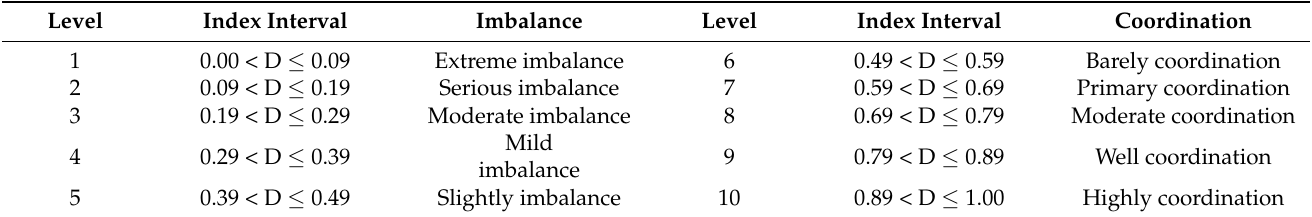
Table 2. Coupling coordination degree